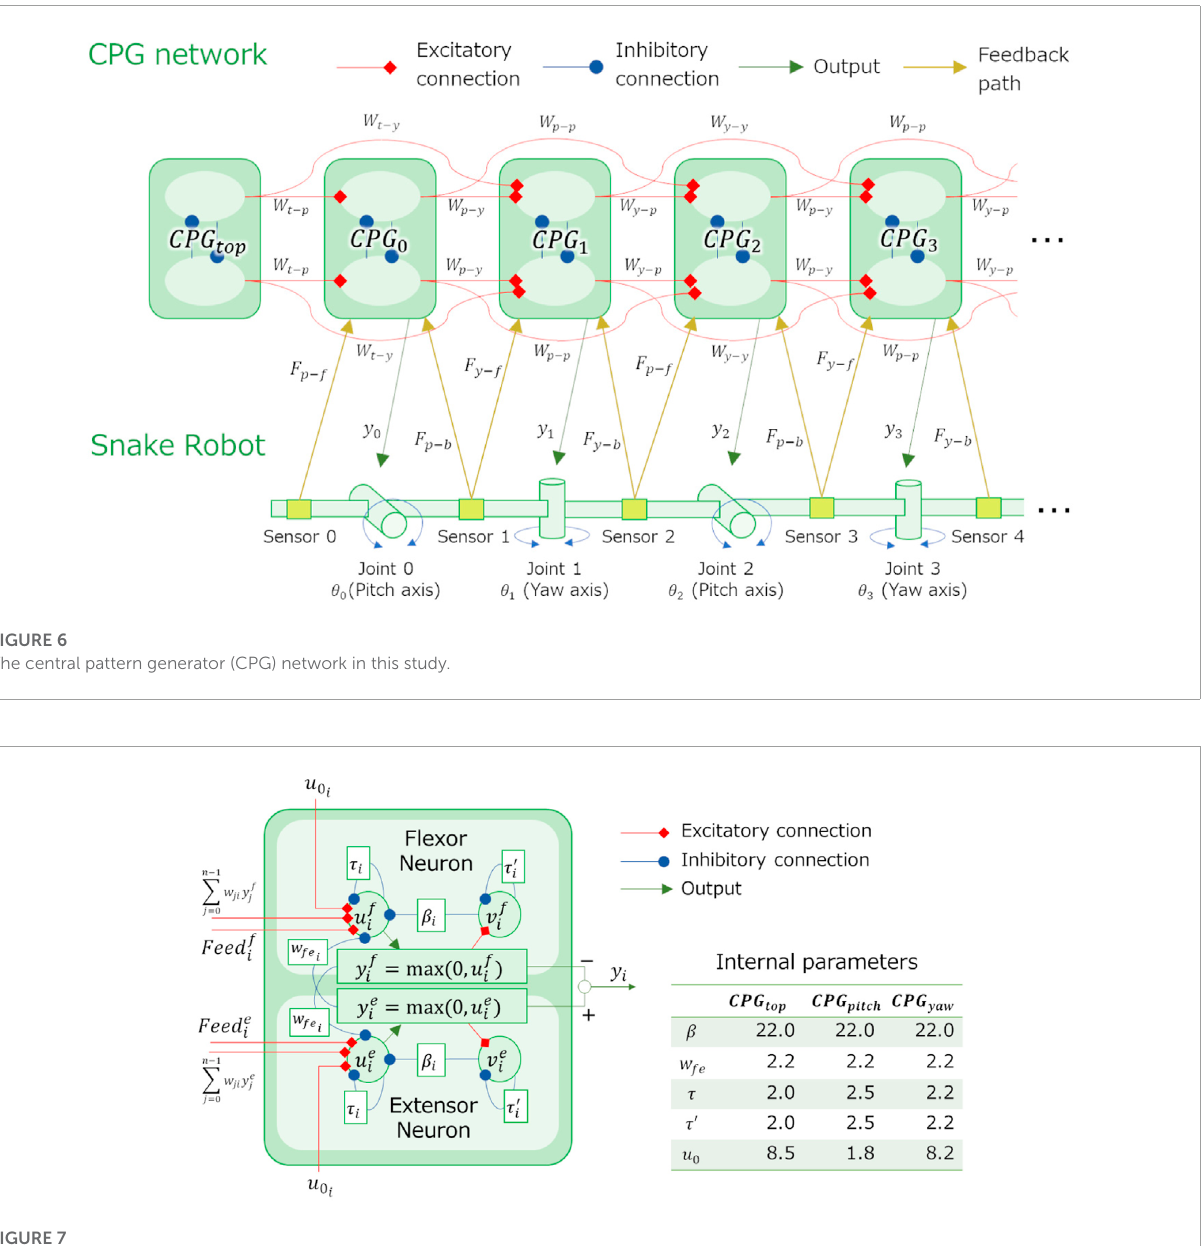
FIGURE 7 CPG model and its